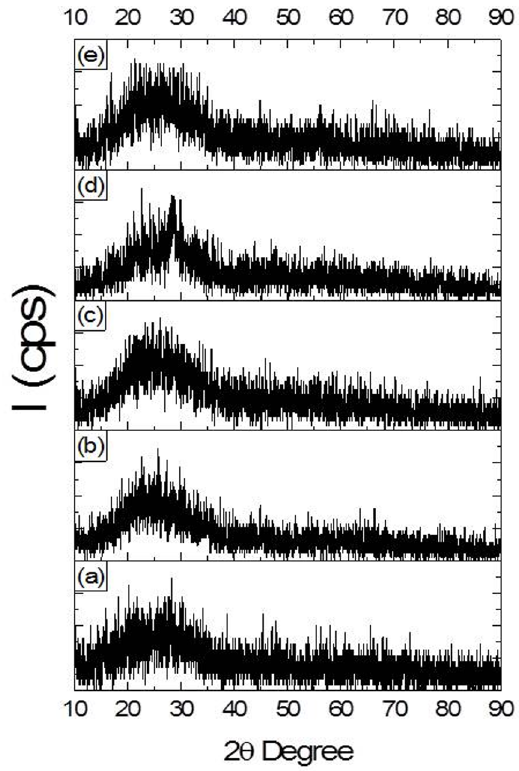
Figure 1. XRD spectrum of Cerium Sulfide thin films produced at different pHs (a) pH: 1, (b) pH: 2, (c) pH: 3, (d) pH: 4, (e) pH: 5.